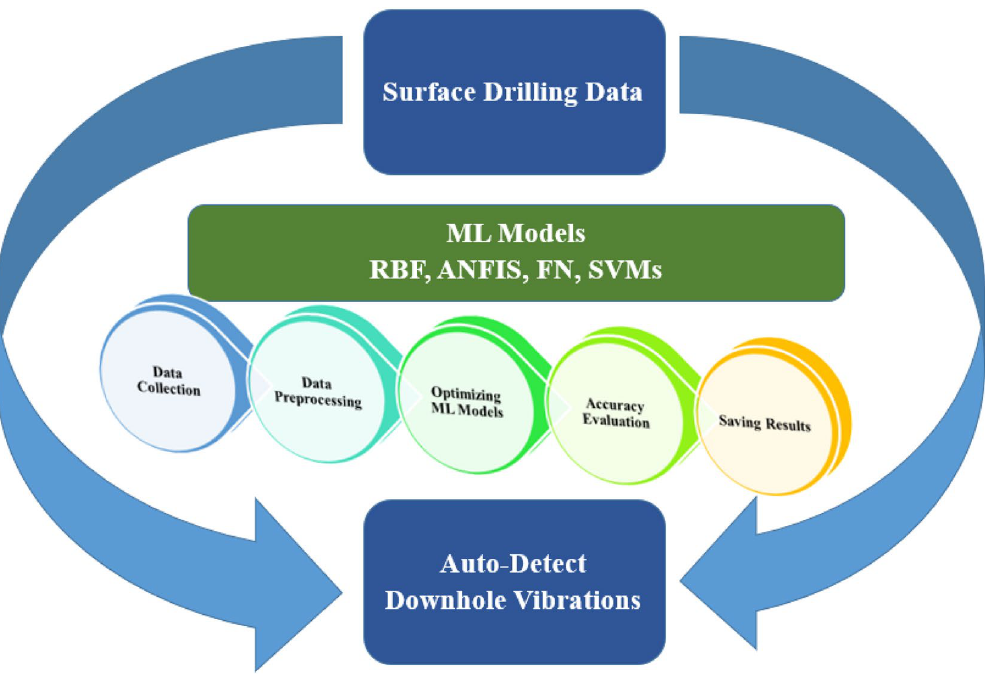
Figure 1. Study approach